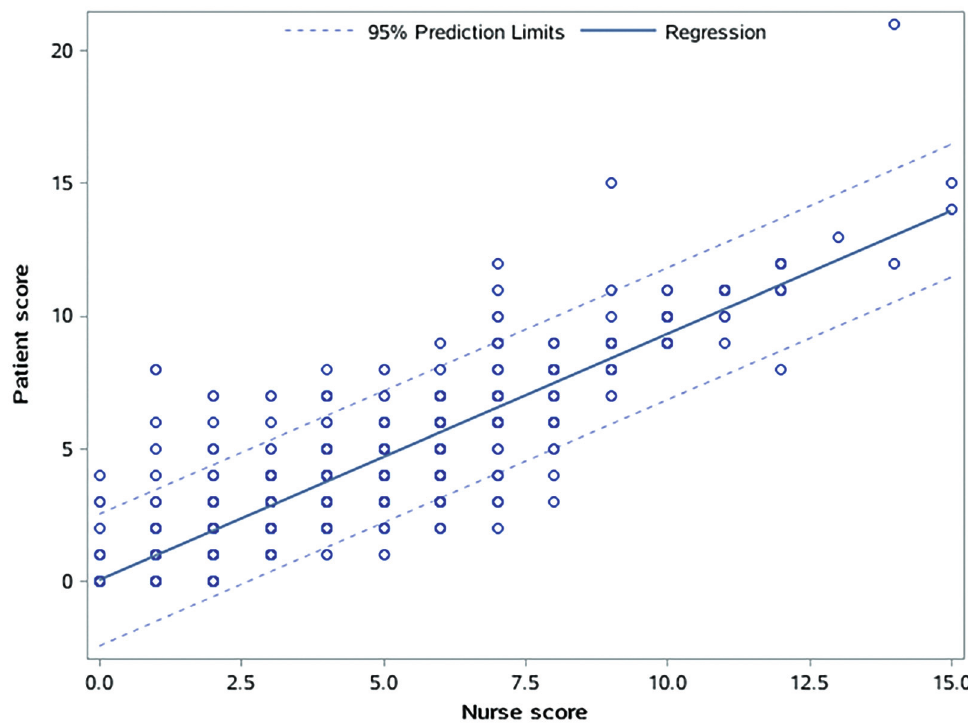
Fig. 2 Correlation between patient-completed and nurse-completed Caprini risk score ( n ¼ 1017). The Spearman correlation coef fi cient was